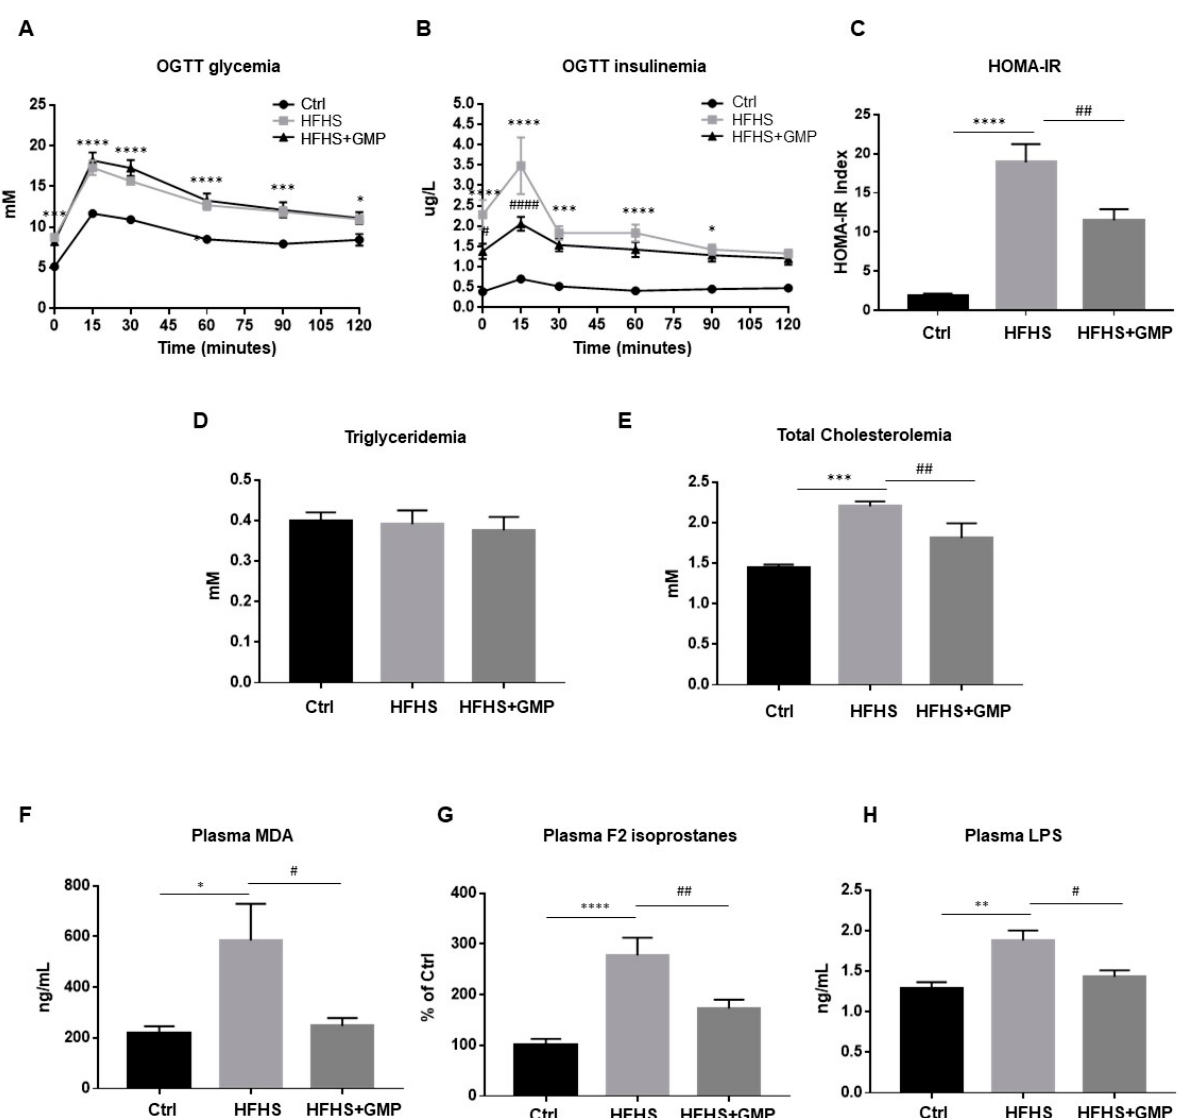
Figure 2. Effect of GMP administration on insulin resistance, dyslipidemia, metabolic endotoxemia as well as on systemic oxidative stress and inflammation in HFHS-fed mice. At week 10, after a 12 h overnight fast, chow (Ctrl), high-fat high- sucrose (HFHS), and HFHS-fed mice supplemented with glycomacropeptide (GMP) were subjected to an oral glucose tolerance test (OGTT). ( A ) glycemia and ( B ) insulinemia were measured as described in Material & Methods. ( C ) Homeostatic model assessment of insulin resistance (HOMA-IR) was calculated. At sacrifice, plasma ( D ) triglycerides, ( E ) total cholesterol, ( F ) Malondialdehyde (MDA), ( G ) F2 isoprostanes and ( H ) Lipopolysaccharide (LPS) concentrations were determined. Data are expressed as the mean ± SEM for n = 10 mice/group: * p < 0.05, ** p < 0.01, *** p < 0.001, **** p < 0.0001 vs. Ctrls; # p < 0.05, ## p < 0.01, #### p < 0.0001 vs. HFHS-fed mice.